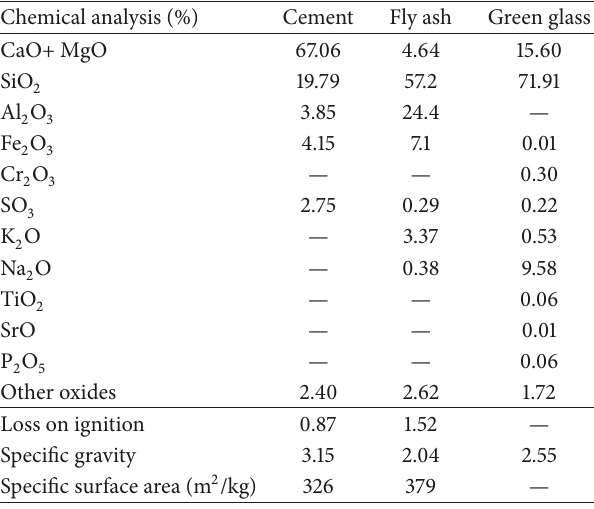
Table 1: Properties of cement and fly ash.